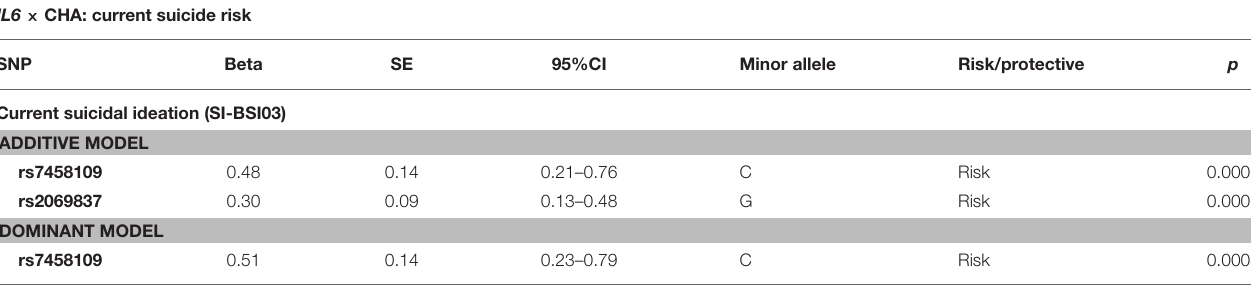
TABLE 3 | Interaction effects between IL6 variation and childhood adversities on current suicidal